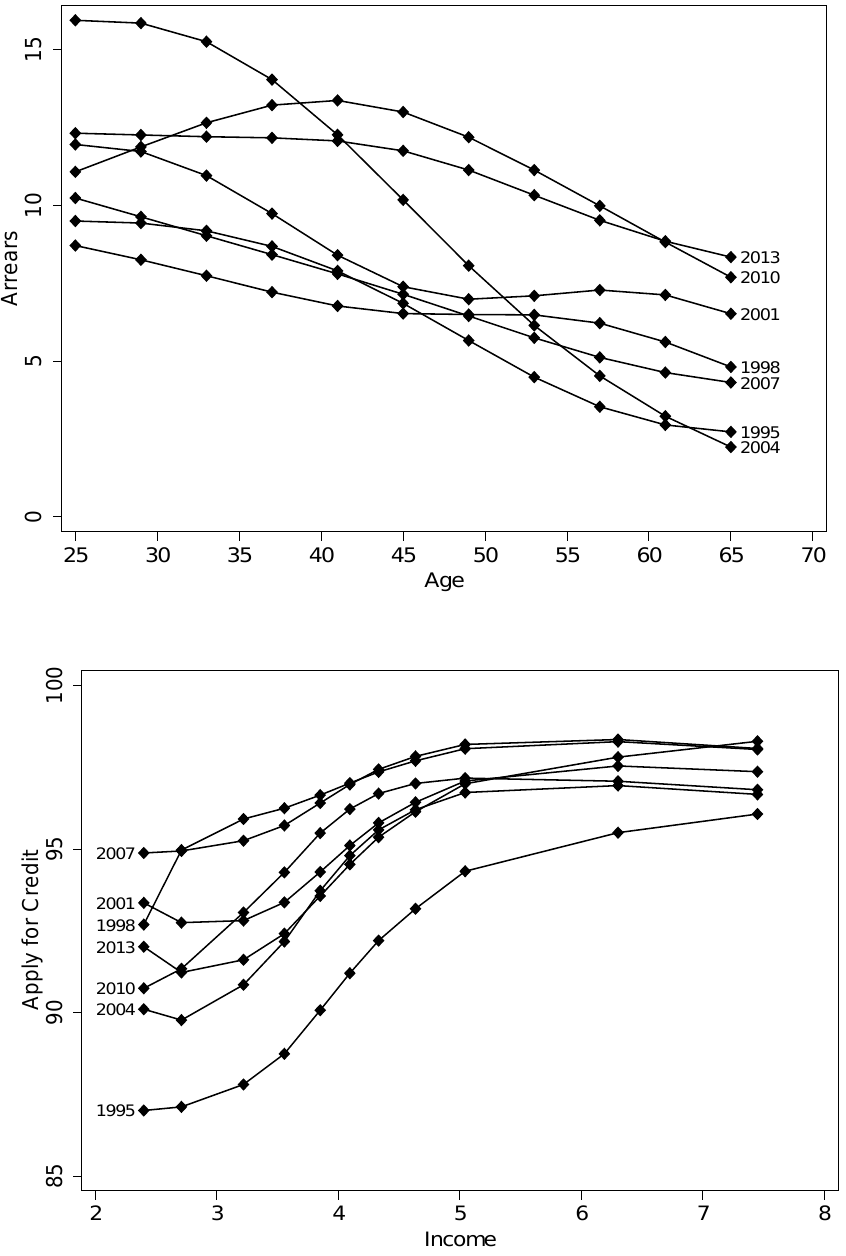
Figure 3. The Effect of Age and Income on Applications for Credit Among Households. Note: These are kernel estimates of the percentage of households that wish to have credit as age/income changes holding the other variables fixed at their median value. The estimates of income are at every 10th centile of the income distribution (and additionally the 5th and 95th